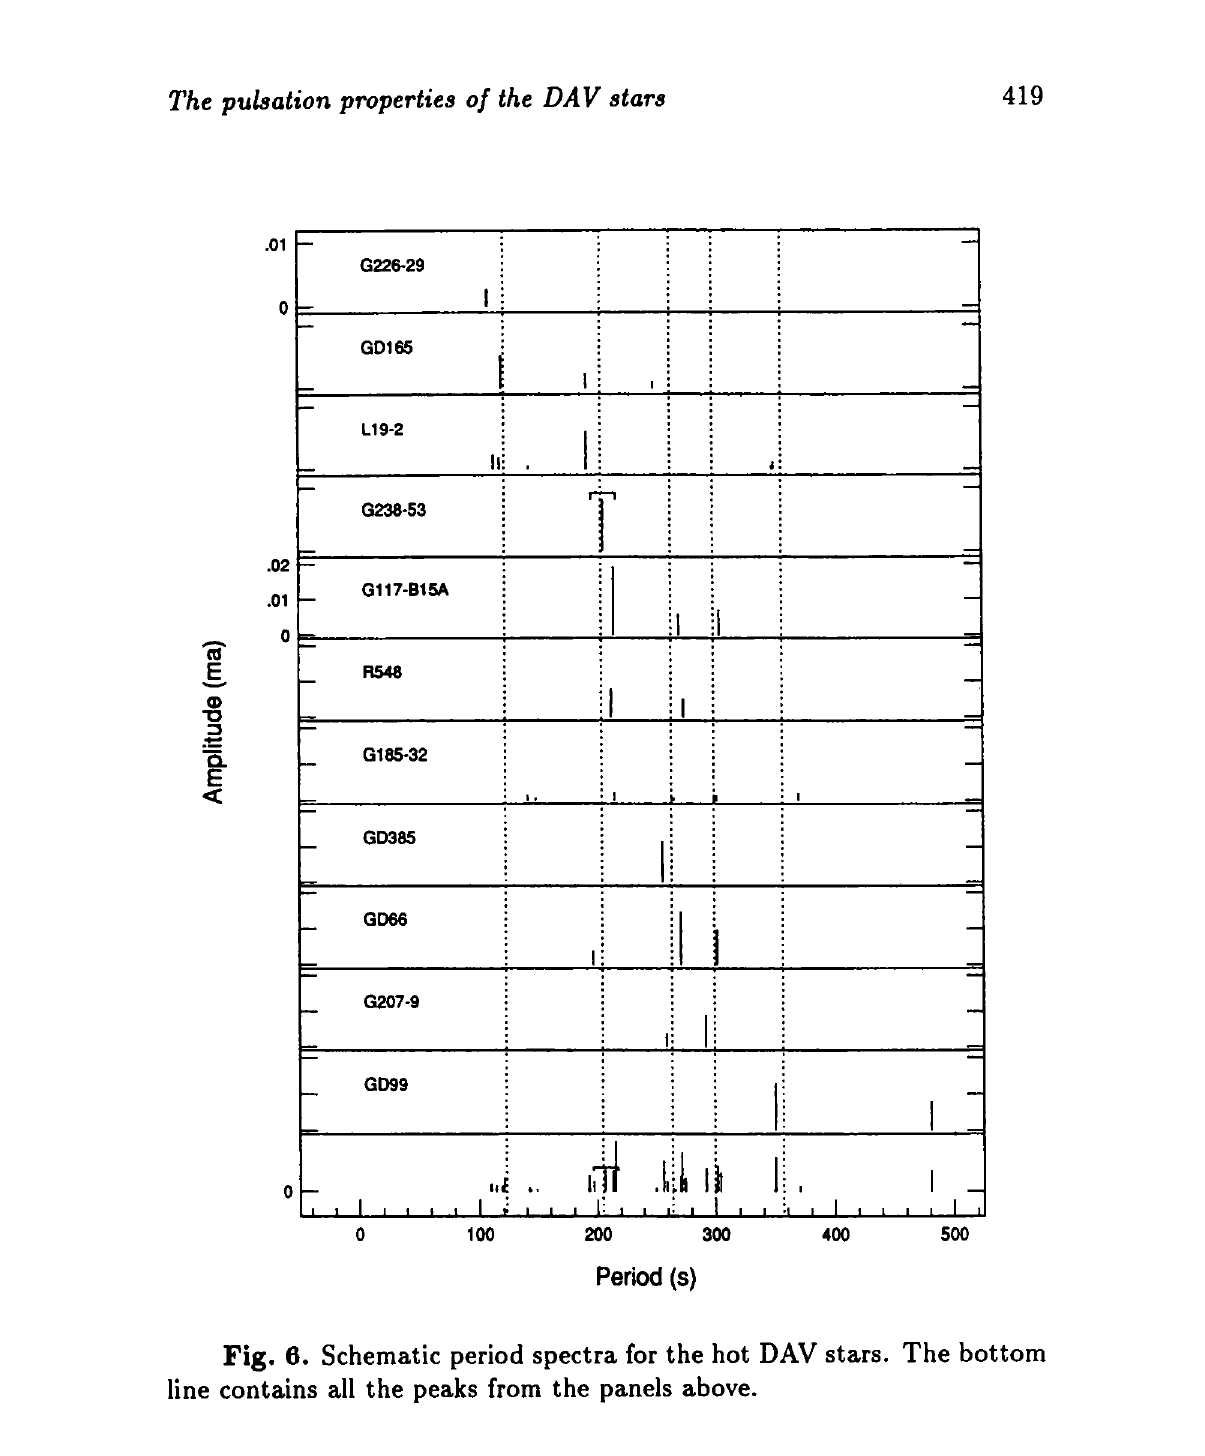
Fig. 6. Schematic period spectra for the hot DAV stars. The bottom line contains all the peaks from the panels